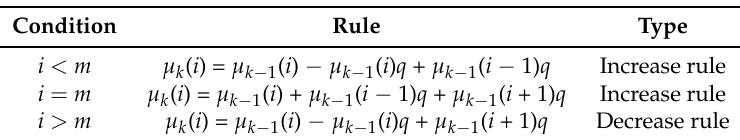
Table 1. Membership grade changing